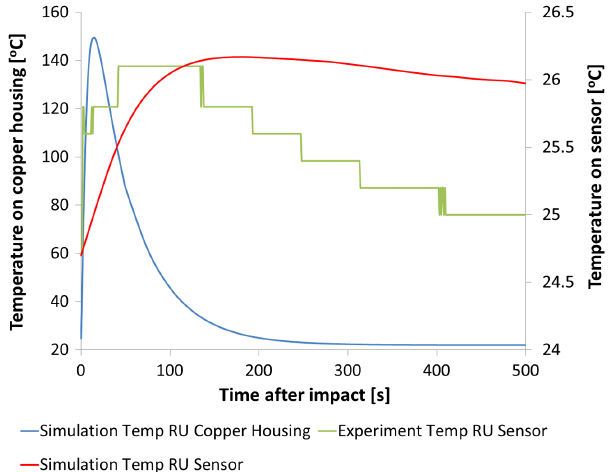
FIG. 19. Comparison of experimental and simulation thermal transients at probe location for Test 3. The left axis represents the temperature at probe location [right upstream (RU)] on the copper housing (blue curve) while the right axis represents the temper- atures given by the sensor (RU) in the experiment (green curve) and in the simulations (red curve). It can be observed that modeling a low contact pressure between the sensor and the copper housing (red curve) gives temperature profiles that are more similar to the ones recorded during the experiment (green curve).